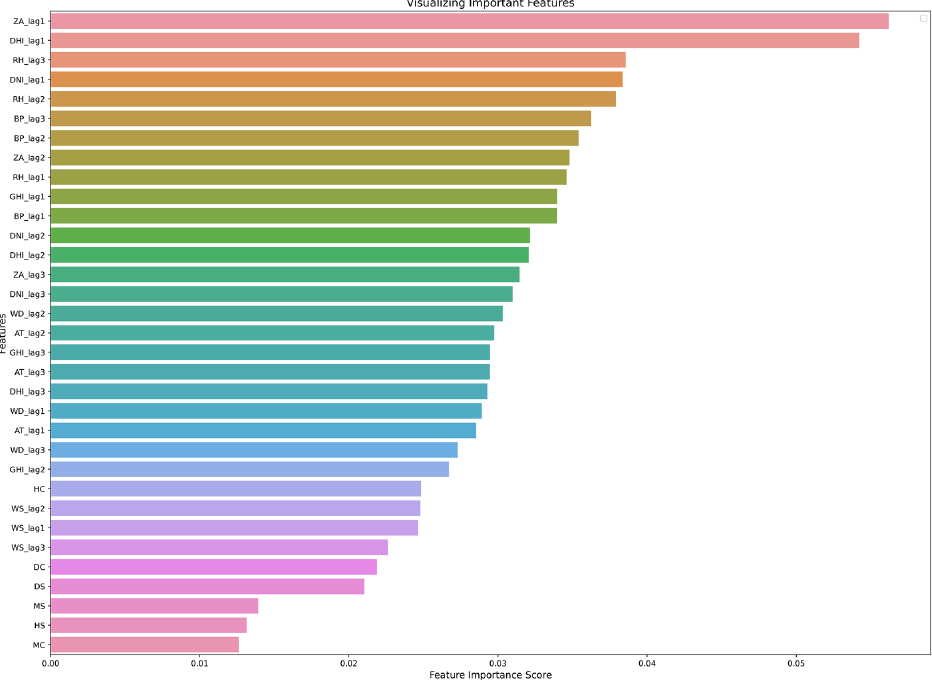
Figure 33. Feature importance using random forest classifier.